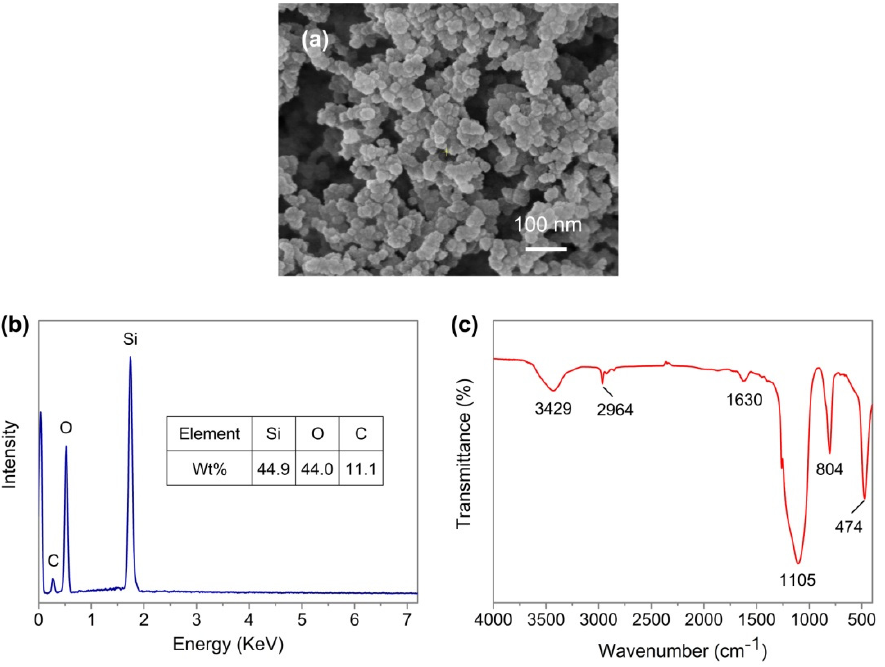
Figure 5. ( a ) SEM image of the Never Wet coating. ( b ) and ( c ) Energy-dispersive diffraction (EDS) and FTIR results of the Never Wet coating.